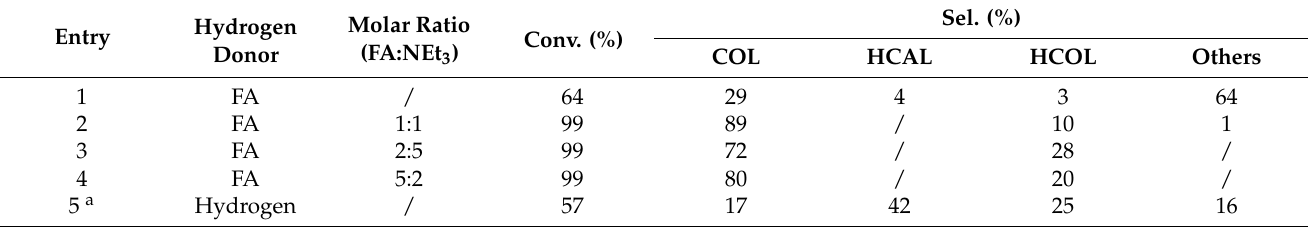
Table 2. Hydrogenation of CAL to COL using different hydrogen donors.